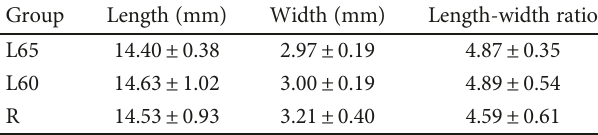
Table 2: The length and width of corneal stripes for each group.